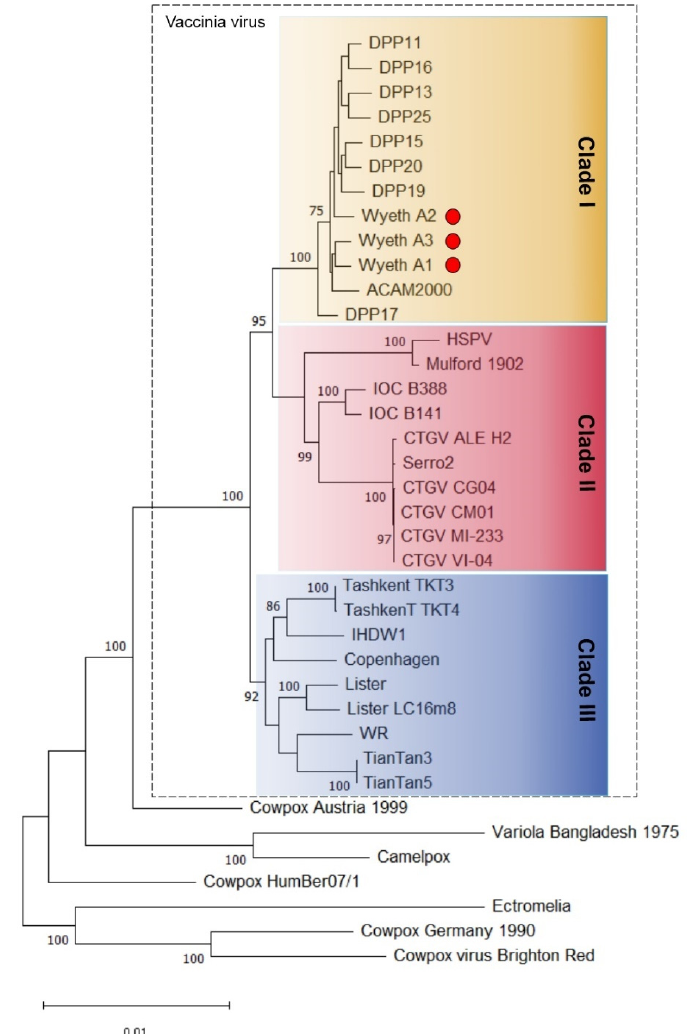
Figure 3. Phylogenetic reconstruction of VACV-Wyeth clones A111, A211, and A311. A multialign- ment of the conserved region of 38 orthopoxvirus genomes was used to infer a maximum likelihood tree using MEGA X, opting for the General Time Reversible (GTR) model and five-category discrete gamma distributed with invariant site. Numbers next to branch nodes indicate the percentage of 1000 replicates of bootstrap support (values >70 are shown). The scale bar indicates the number of substitutions per site. Colored boxes indicate the three main clades in the vaccinia group. The Wyeth clones are indicated with red circles.